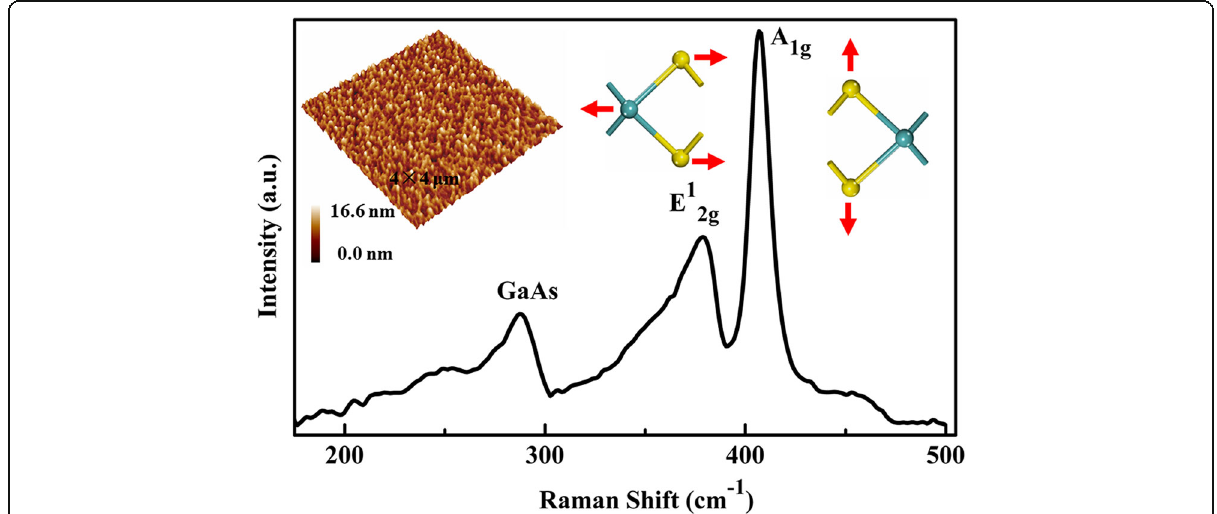
Fig. 1 Raman spectrum of the MoS 2 film on GaAs. The right two insets show the schematic illustrations of the oscillating mode of E 1 2g and A 1g , respectively. Atom color code: light blue-green, Mo; yellow, S. The left inset shows the surface morphology image of the as-grown MoS 2